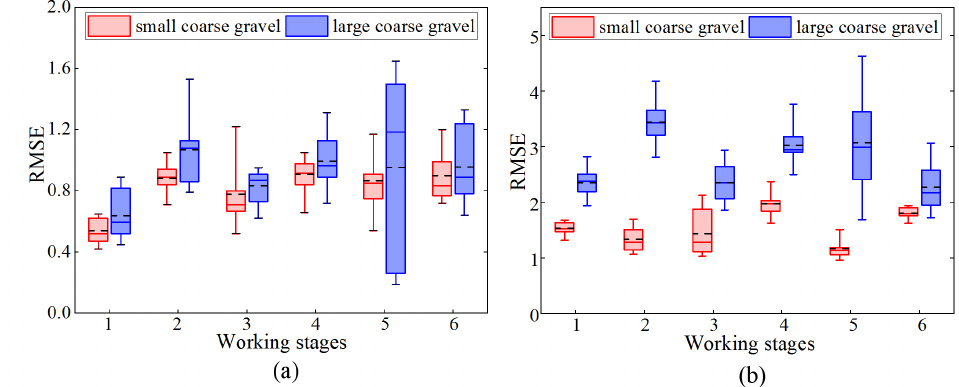
Figure 8. Comparison of RMSE from different materials: ( a ) prediction of throttle value ( b ) prediction of state. mean and median values are shown with ‘–’ and ‘—’